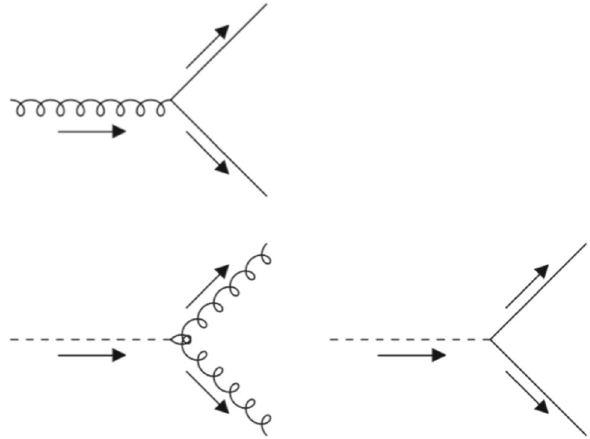
Fig. 5 Possibledecaysofthegaugeboson(above)andtheHiggsboson (below). The arrows indicate the momentum flow